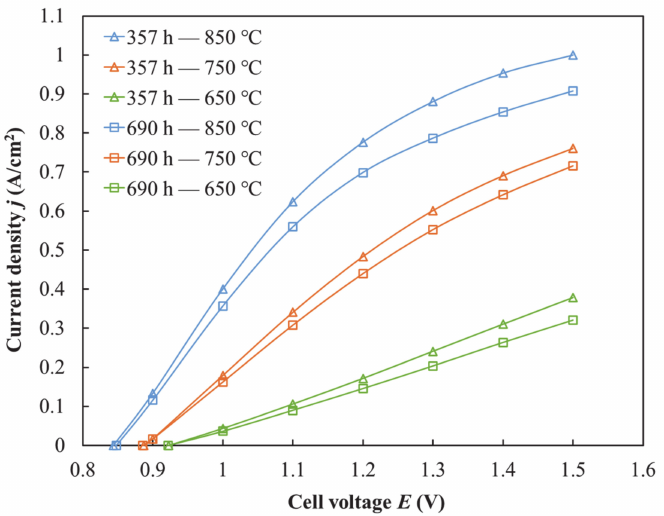
Figure 6. Current density vs. cell potential curves of the Ni-YSZ|YSZ|GDC|PSC short stack in the electrolysis regime at different operation times and temperatures noted in the